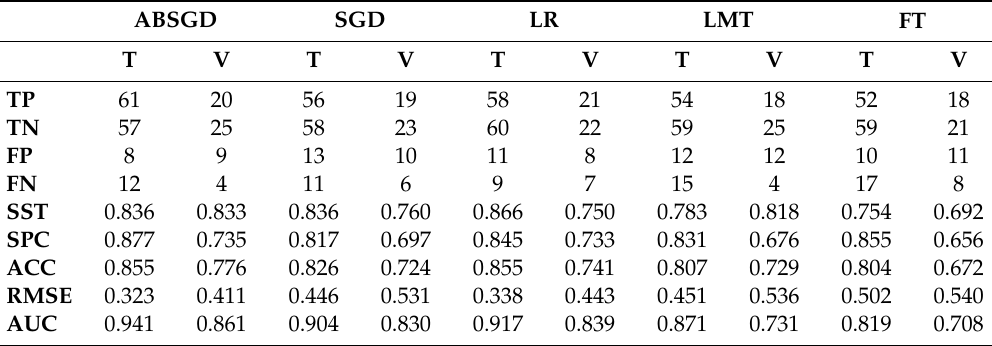
Table 3. Model results and analysis using training and validation datasets.